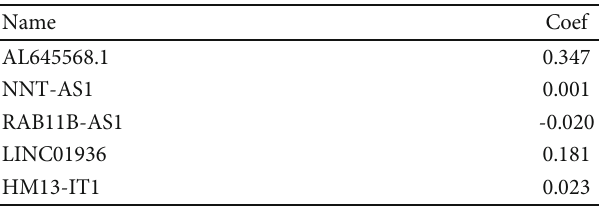
Table 3: Key prognostic N6-methyladenosine-relevant long noncoding RNAs and their coe ffi cients